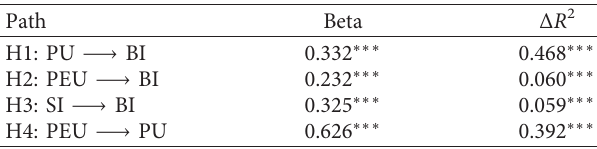
Table 4: The results of hypothesis